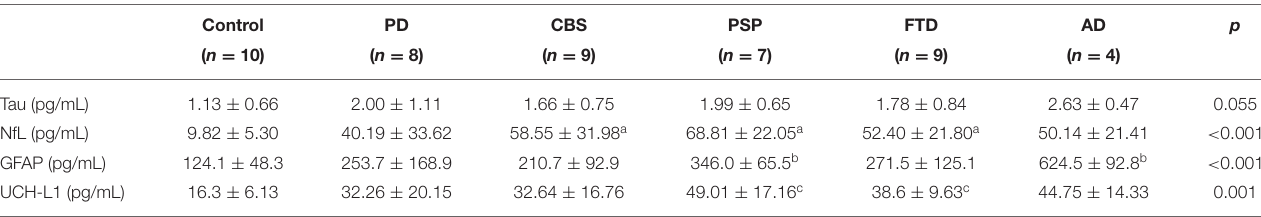
TABLE 3 | Plasma biomarkers in individual disease groups. Control